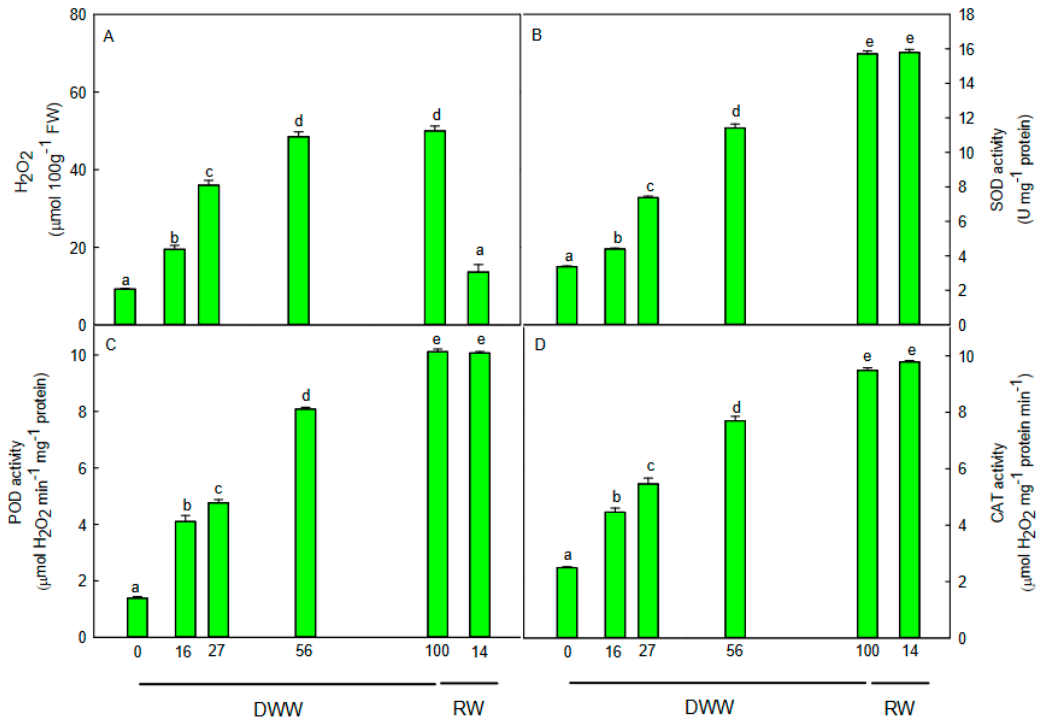
Figure 3. Trends of ( A ) H 2 O 2 content, ( B ) superoxide dismutase (SOD) activity, ( C ) peroxidase (POD) activity, and ( D ) catalase (CAT) activity during days without water (DWW), and rewatering (RW). Different letters indicate statistically significant differences ( p ≤ 0.05) among different days. Data were analyzed by one-way ANOVA repeated measurements followed by the Tukey’s test. Data are means ( n = 10) ± SE.